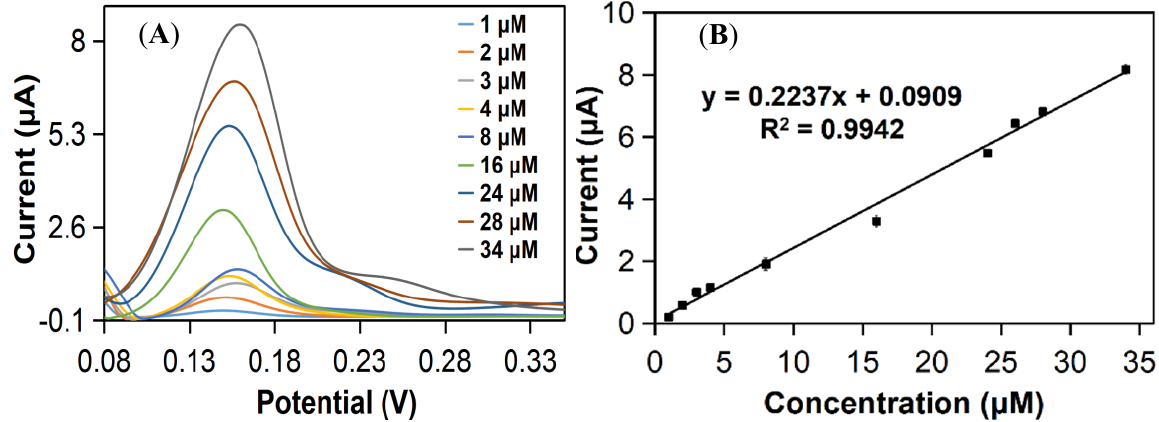
Figure 5. ( A ) DPV of the mp20@ZIF-8/rGO/SPCE after spiking of different uric acid concentrations in 0.1 M PBS at pH 7.4, and ( B ) calibration curve of current density as a function of the UA concentration.